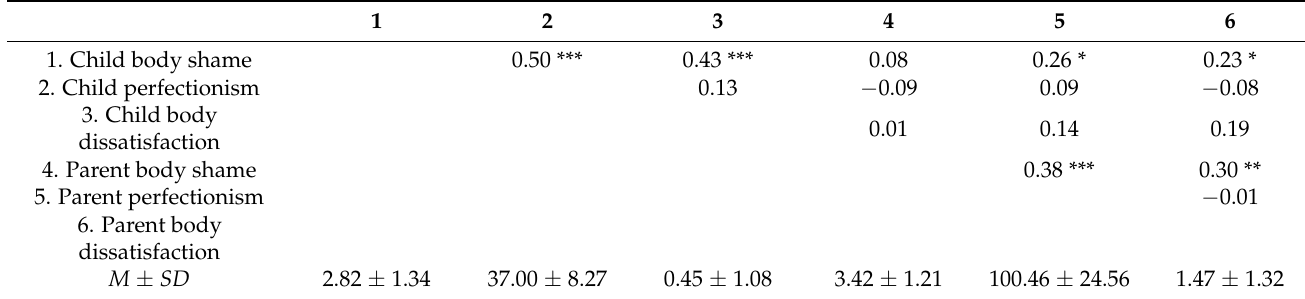
Table 3. Descriptive statistics and correlations of parent-child dyads in Italy.